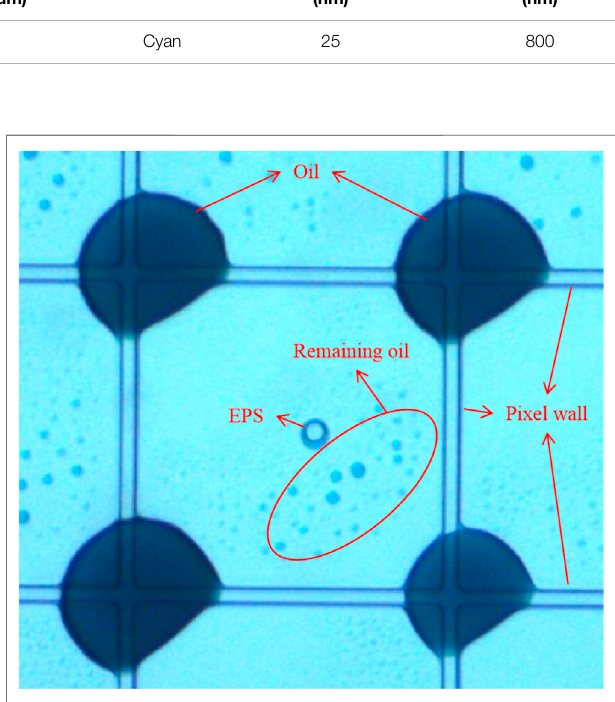
FIGURE 8 | Top view of pixels when the oil fi lm over fl owed to the pixel wall. When the EWD panel was driven by a high voltage, the oil fi lm gathered on thepixelwall. When the driving voltage wasremoved, the amount of oil fi lm in the pixel grid changed, and the oil fi lm could not cover the whole pixel, which made the pixel unable to close. The circle in the middle of the pixel was an extra pinning structure (EPS). The random black spots in pixels were the residual